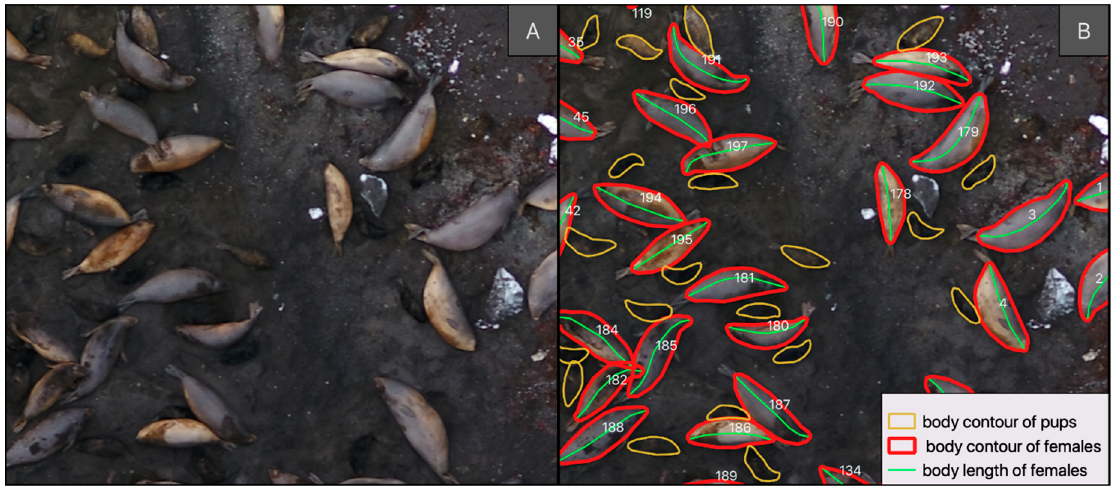
Figure 3. Selected area of the main harem on October 24 ( A ); the same area showing the method used for image processing ( B ).